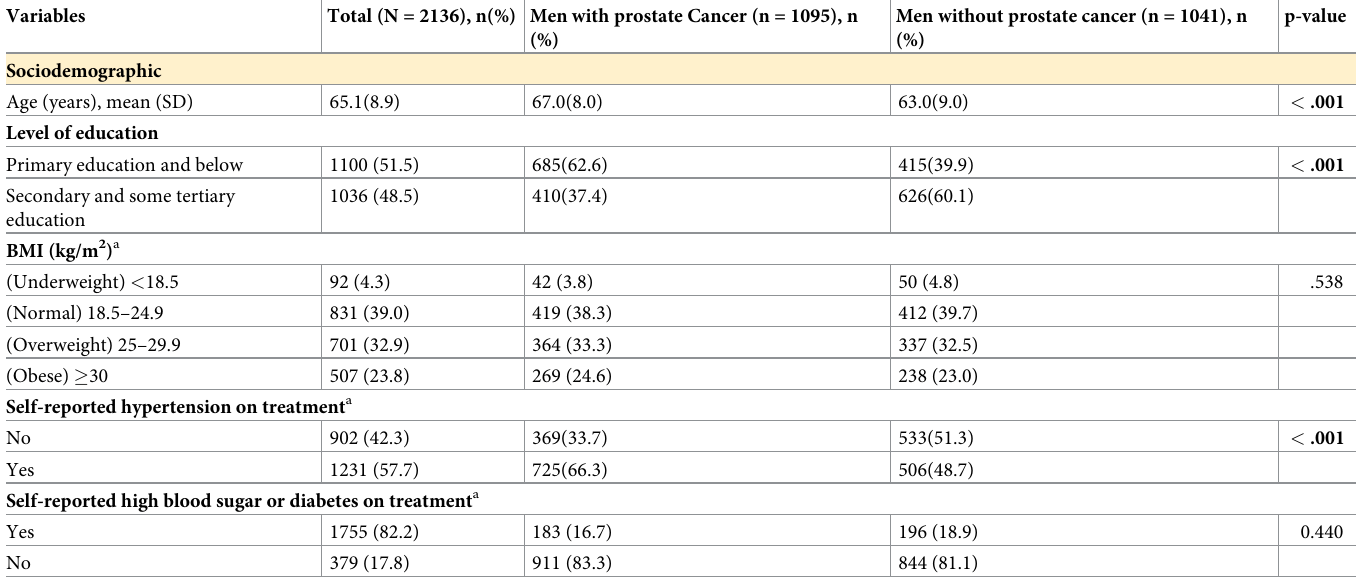
Table 1. Self-reported sociodemographic and multimorbidity in men with and without prostate cancer.